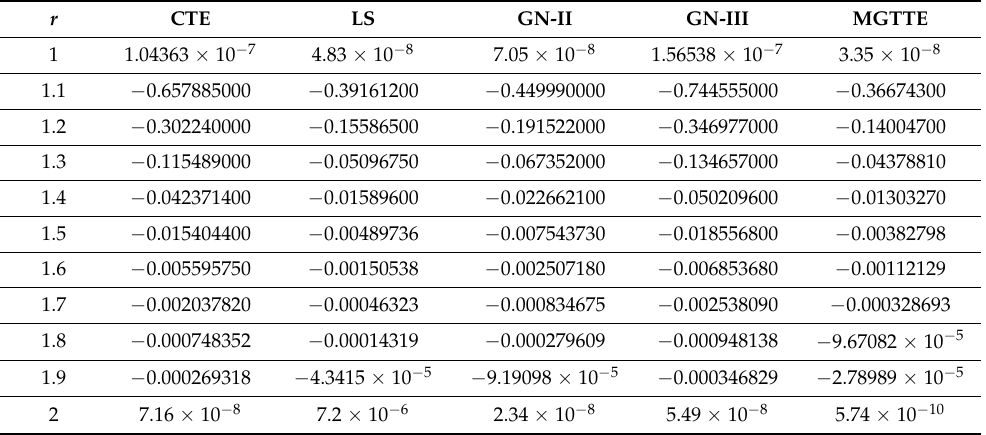
Table 5. The induced magnetic field, h , versus different models of